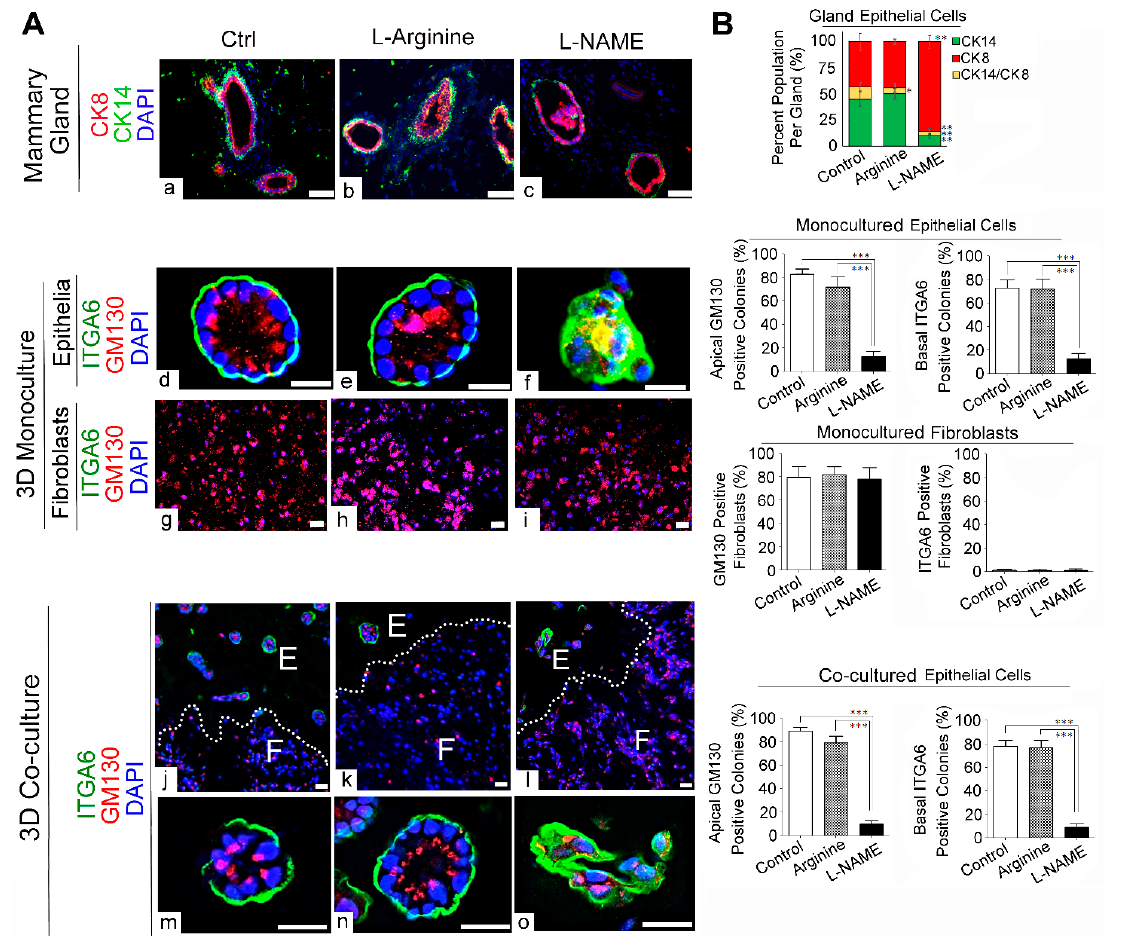
Figure 6. L-NAME treatment induced the outgrowth of luminal epithelial cells and loss of apico–basal polarity in mammary acini in vivo and in 3D mono- and co-cultures. ( A ) Representative micrographs of drug-treated samples. ( a – c ) Drug-treated mouse mammary glands as in Figure 3 (Control, L-arginine- and L-NAME-treated) were stained with antibodies against CK8 (luminal epithelial cell marker) and CK14 (myoepithelial marker). Note the dramatic increase in CK8 level and decrease in CK14 level in L-NAME-treated glands. ( d – i ) Drug-treated 3D mono-cultures of MECs ( d – f ) and fibroblasts ( g – i ) as in Figure 3 were stained with GM130 (apical marker) and integrin α 6 (ITG6, basal marker). Note the aberrant apical polarity in L-NAME-treated MEC colonies ( f ). ( j – o ) Drug-treated organotypic 3D co-cultures of MECs (E, glandular epithelial structures) and MFs (F, connective tissues) as in Figure 3 were stained with GM130 (lumen marker) and ITG6 (basal marker). Note the loss of apical marker and disorganized basal marker in MECs in L-NAME-treated co-cultures ( l , o ). Scale bars: 50 μ m. ( B ) Quantification of signal intensity of different markers analyzed in micrographs of ( A ) (Top) Percentage of CK14 (basal, CK8 (luminal) and CK14/CK8-positive cells in each gland. Data are presented as the arithmetic mean ± SEM. * p < 0.05; ** p < 0.01; and *** p < 0.001.